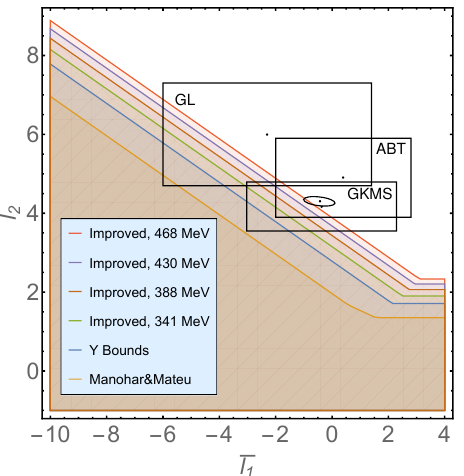
Figure 10 . Improved Y bounds on (cid:22) l 1 and (cid:22) l 2 for the (cid:25)(cid:25) scattering to one loop for di(cid:11)erent (cid:15) (cid:3) subtractions. For example, the red line is for (cid:15) (cid:3) M (cid:25) = 468 MeV. \Y bounds" indicates no (cid:15) (cid:3) subtraction and \Manohar&Mateu" is the bounds from [18]. The rectangles GL, ABT, GKMS and the small ellipse inside it are the ranges of the (cid:12)tted values of (cid:22) l 1 and (cid:22) l 2 given in [3, 72, 73] and [71] respectively.